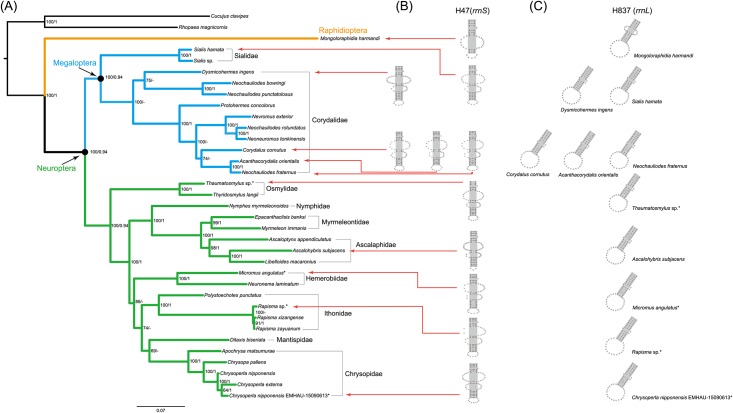
Phylogenetic reconstruction and secondary structure drawings of the helices.(A) Phylogenetic reconstruction from PCG12RNA using software IQ-TREE under the partitioned models automatically selected. Node values represent bootstrap values (left) and posterior probabilities (right). The “-” indicates the relationship not being retrieved by the data set of PCG12RNA using software PhyloBayes under CAT-GTR model. Asterisks designate the species newly sequenced in this study. (B) Secondary structure drawings of the helix 47 in rrnS for eleven representative neuropterid species. (C) Secondary structure drawings of the helix 837 in rrnL for eleven representative neuropterid species.